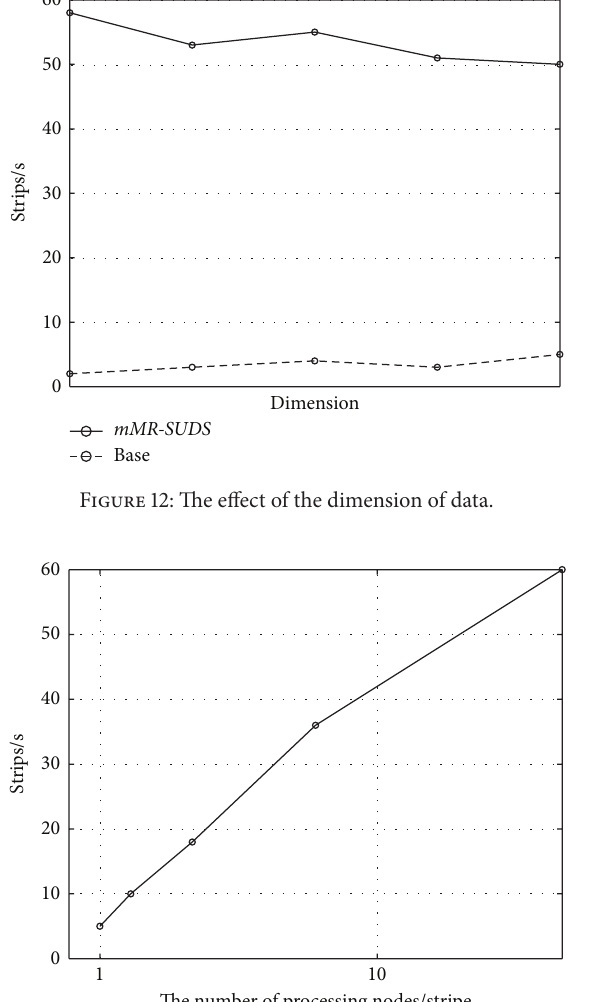
about 12 times higher than that of Base algorithm